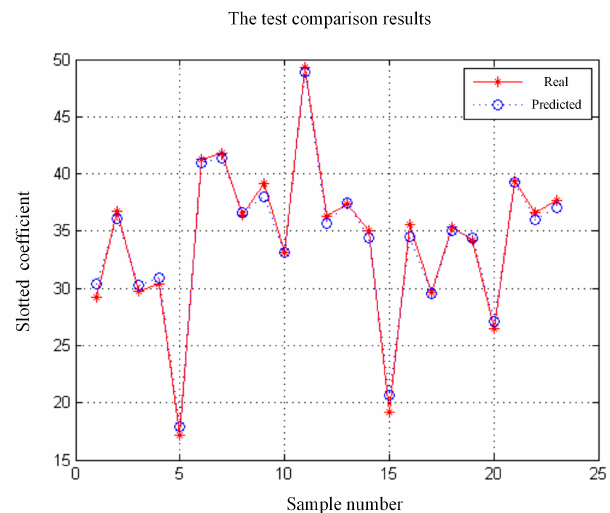
Figure 8. The test comparison results.